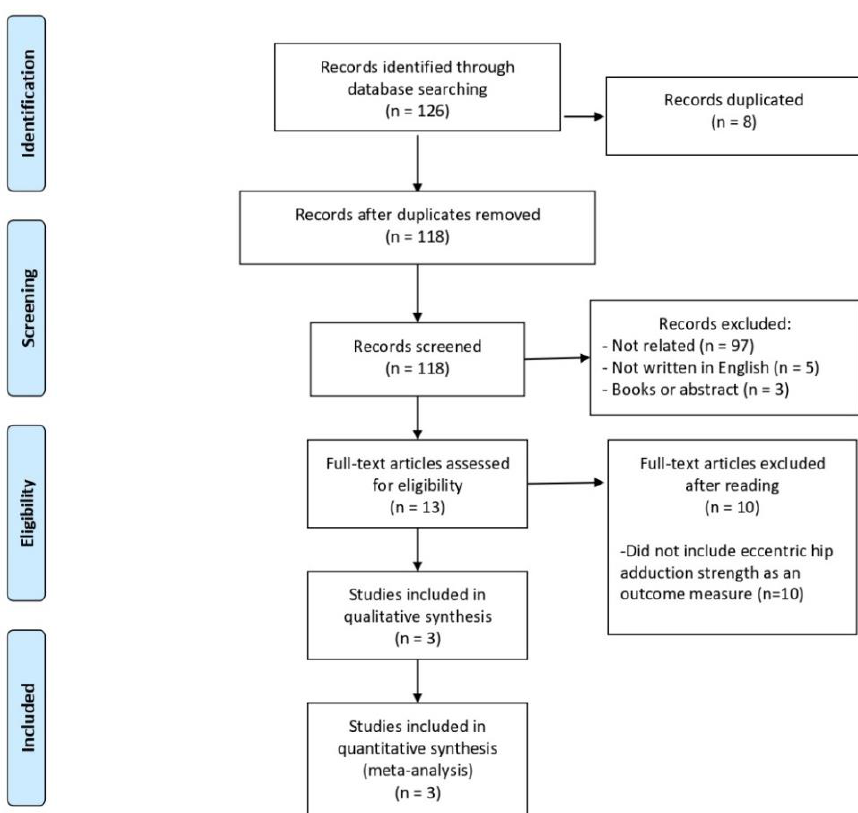
Figure 1. Flow chart for selection of studies according to PRISMA statements.